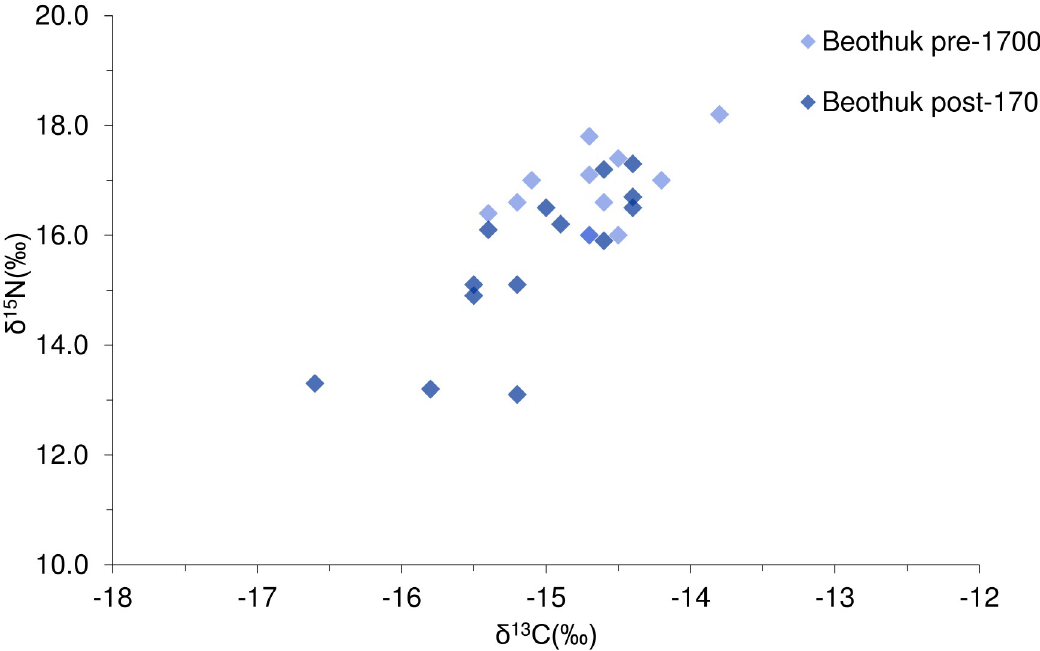
Fig 4. The δ 13 C and δ 15 N values of Beothuk individuals. The samples are separated chronologically by the median radiocarbon date of each sample. Includes published data from Duggan et al. 2017 and Kuch et al. 2007.